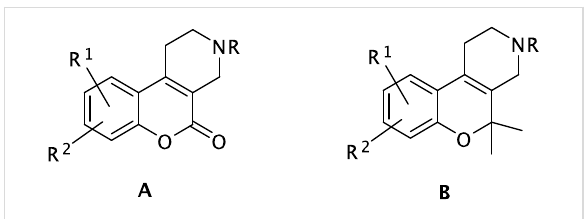
Figure 1: General structures A & B , Tetrahydro cannabinole derivat- ives.